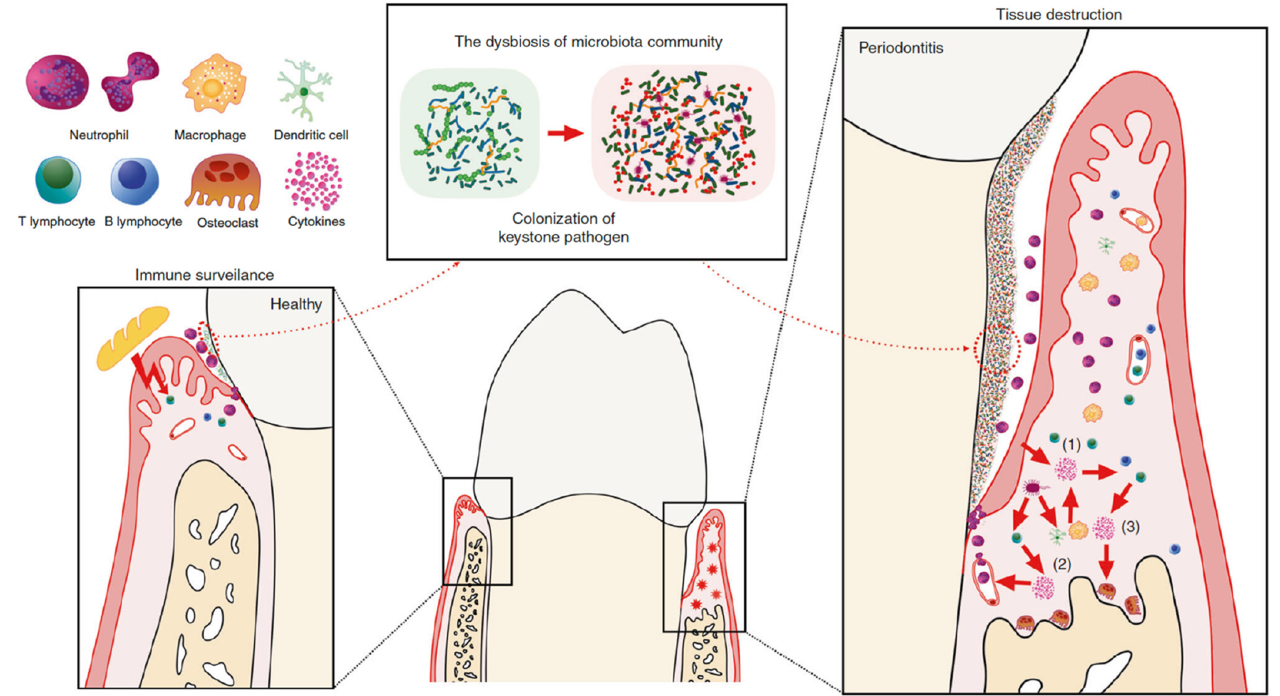
Figure 1. The periodontal homeostasis, CP pathophysiology, and roles of the concerned cytokines. Local challenge and a slight host immune response are balanced in health. The commensal bacteria and mechanical spur from mastication contribute to the development of local mucosal immunity. An adequate infiltrating neutrophil in the gingival sulcus, as well as several resident immune cells in the gingival tissue, such as T helper (TH) 17 cells and innate lymphoid cells, are adequate in this condition. Nonetheless, if the immunological pathogenicity of this microbiota is increased by the colonization of keystone pathogens, tissue damage occurs due to hyperactivity of the host immune response. The interface between the microbiota and host cells results in the primary wave of cytokine emission (1) that primarily contributes to the intensification of the pro-inflammatory cytokine cascade as well as the recruitment, activation, and differentiation of certain immune cells. Furthermore, mononuclear phagocytes and antigen presenting cells release a group of cytokines (2) that are strongly associated to the differentiation of a particular subset of lymphocytes after being stimulated by the